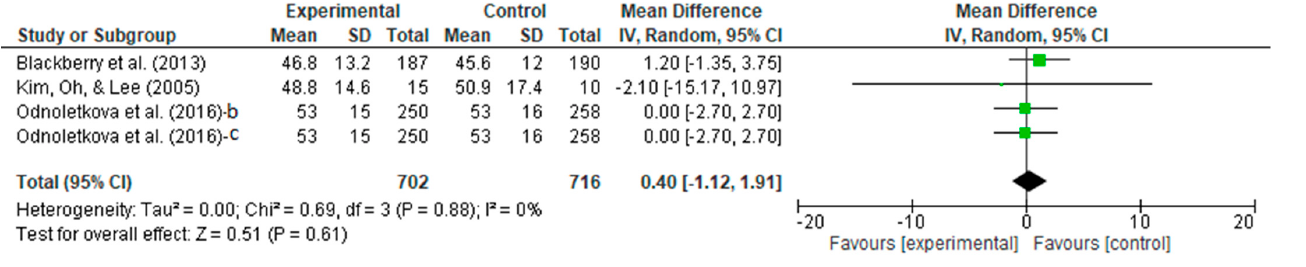
Figure 11. Forest plot intervention vs. control of telecoaching in achieving an HDL outcome [12,16,21,22].